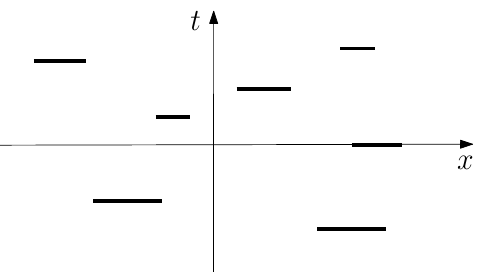
Figure 2. A collection of horizontal segments in the complex